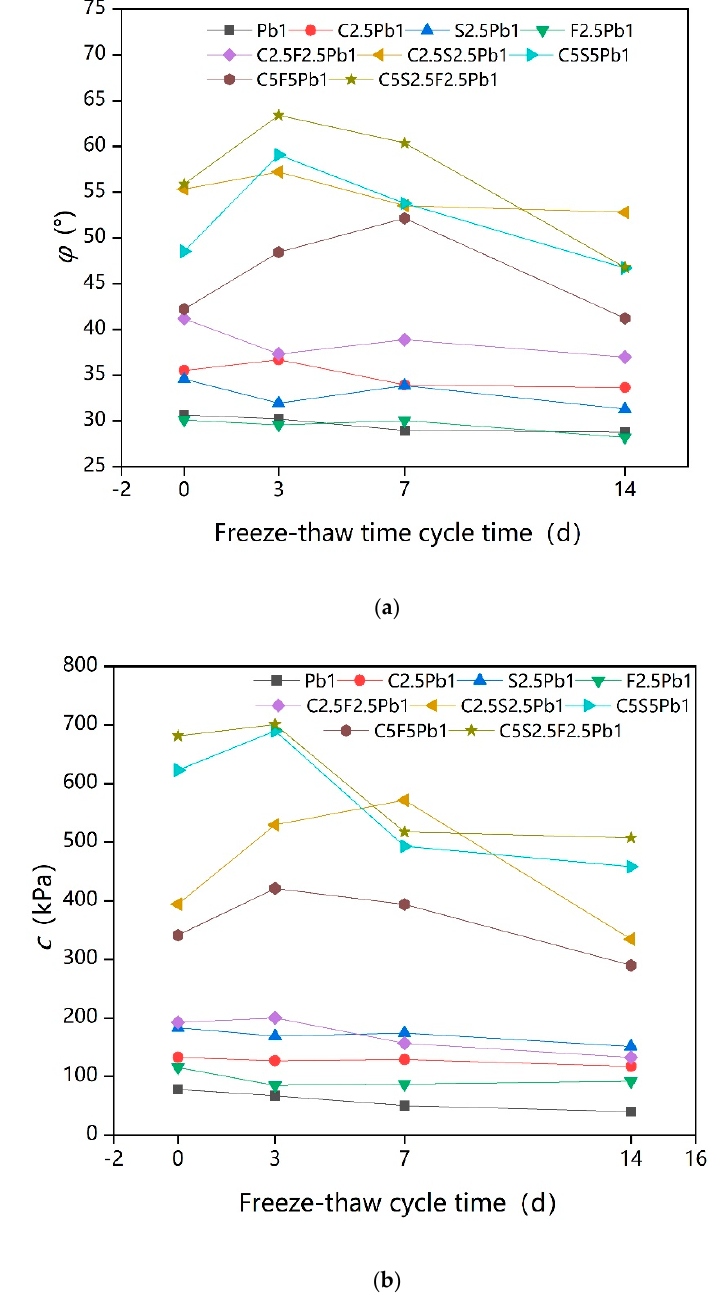
Figure 8. The shear index of solidified lead-contaminated soils under freeze–thaw cycles: ( a ) The internal friction angle ( 𝜑 ) of solidified lead-contaminated soils under freeze–thaw cycles; ( b ) The cohesion ( 𝑐 ) of solidified lead-contaminated soils under freeze–thaw cycles.